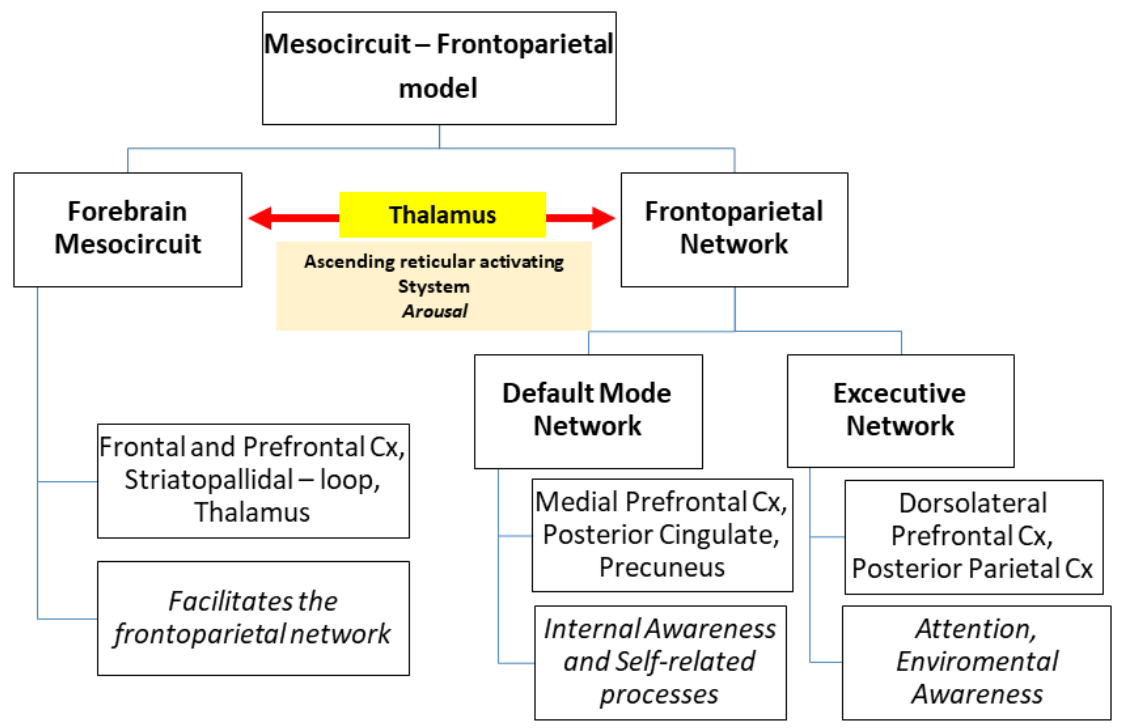
Figure 1. Mesocircuit—Frontoparietal Model. The diagram shows the interrelationship between the forebrain mesocircuit, the frontoparietal network, and the ascending reticular activating system. The function of each system is reported in italics. Cx: cortex.